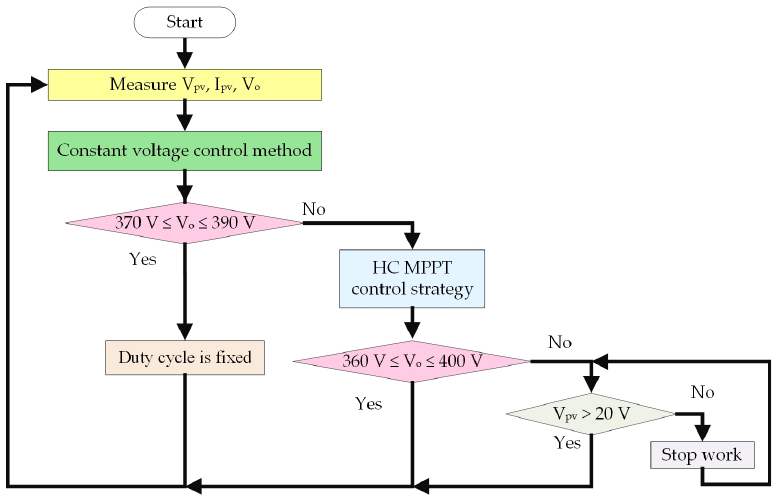
Figure 4. Flow chart of the constant voltage control method combined with the HC MPPT control strategy.